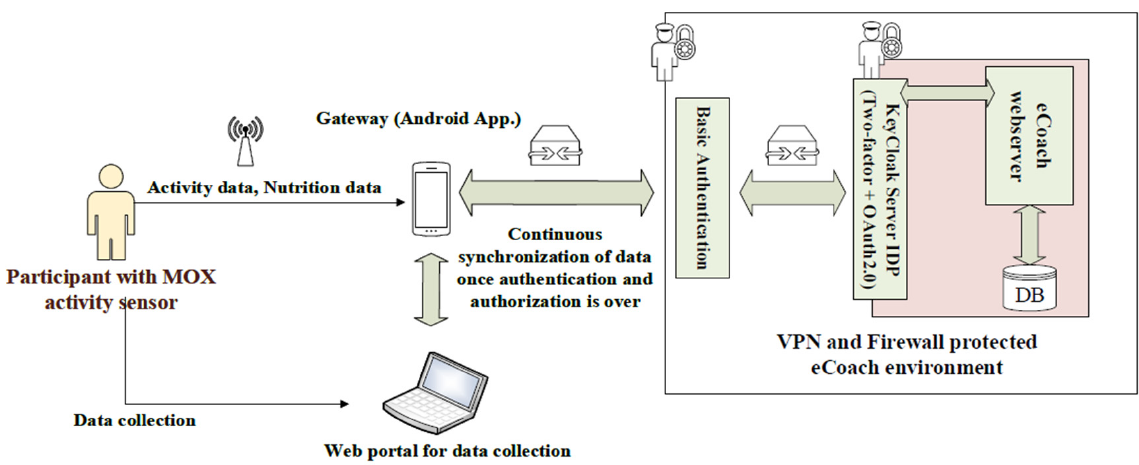
Figure 2. Deployment of eCoach system in the developed digital health infrastructure with extended SSK features.